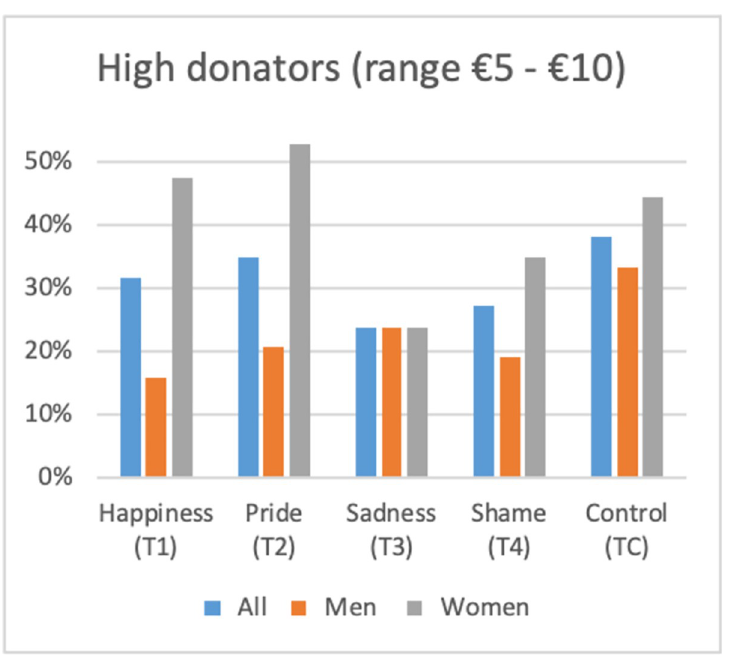
Fig 2. High-level donations and gender effect (by